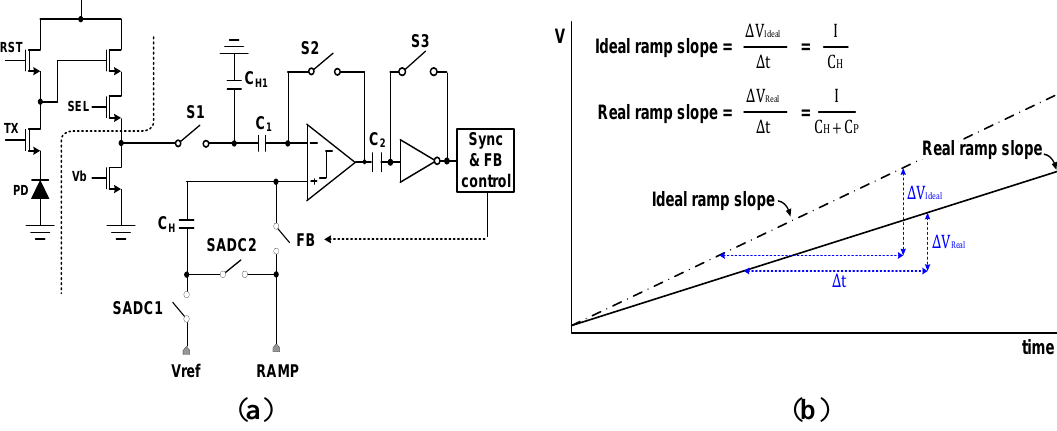
Figure 2. Circuit diagram and ramp slope change of TS SS ADC: ( a ) circuit diagram for a conventional TS SS ADC; ( b ) ramp slope change by parasitic